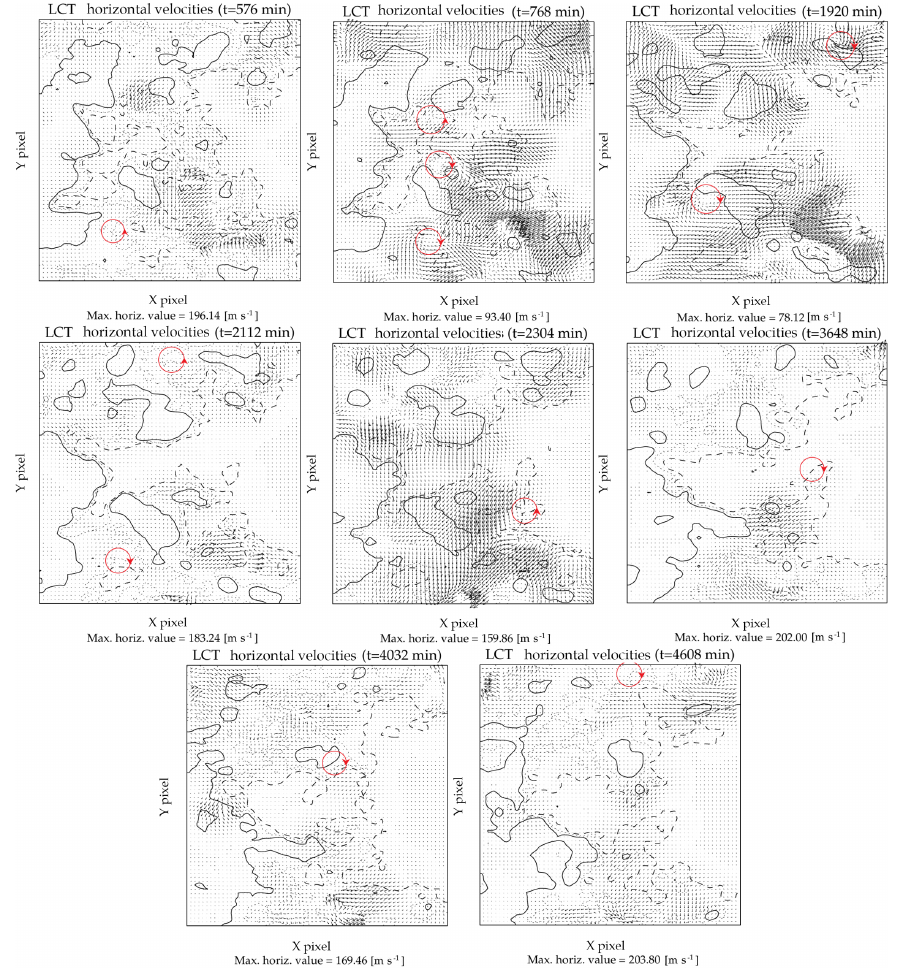
Figure 4. Location of the detected vortex flows in the 2-D LCT flow fields obtained from the evolution of the magnetic structures around the PIL of a fully developed active region. The red circles indicate their location, and the arrows indicate the direction of rotation.